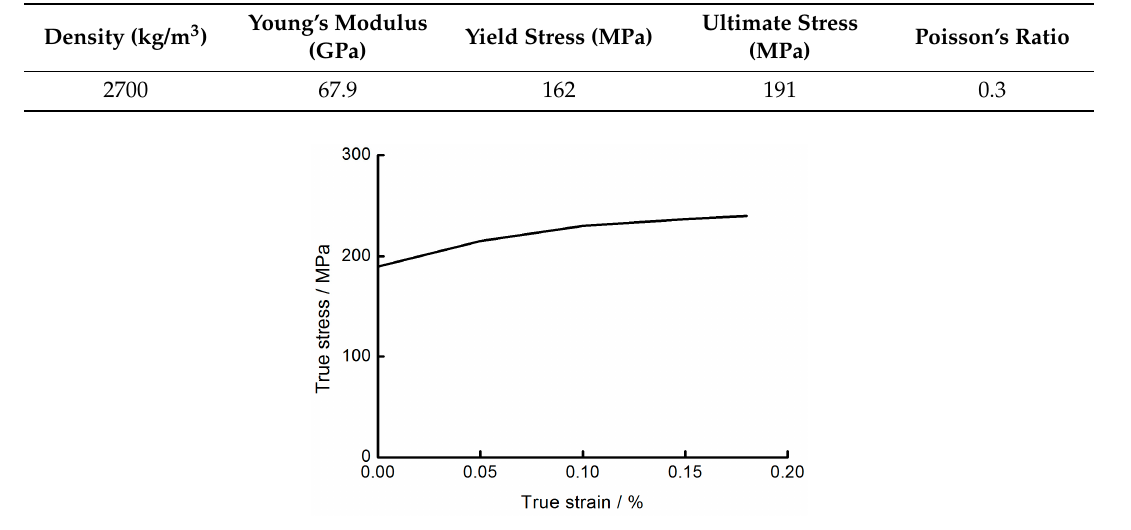
Figure 7. True stress versus true strain curve for AA6063.